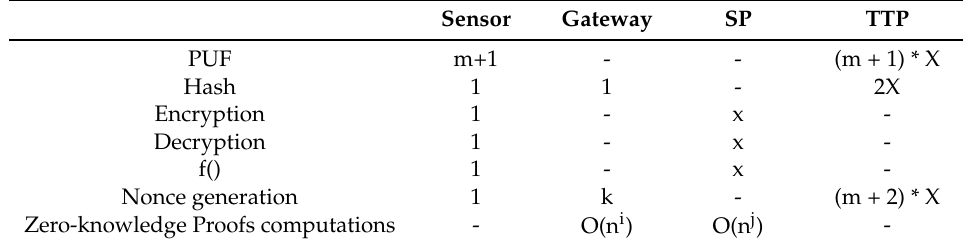
Table 4. Comparative computing resource analysis between communication objects.